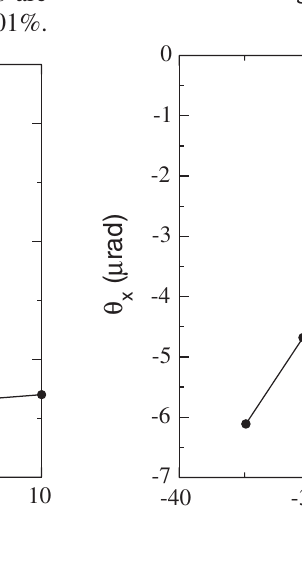
FIG. 6. The horizontal kick error (cid:1) is a nonlinear function of x Þ when a sextupole error is present. the trajectory excursion x ð s (cid:1) A quadratic fit of the plot gives the sextupole